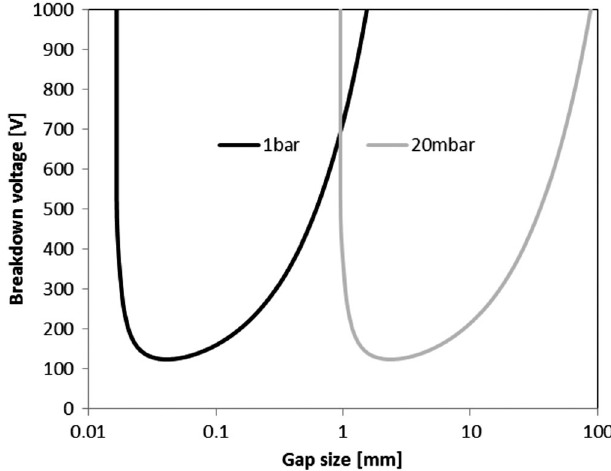
FIG. 14. Paschen ’ s law curves for breakdown voltage in helium at 1 bar and at 20 mbar.